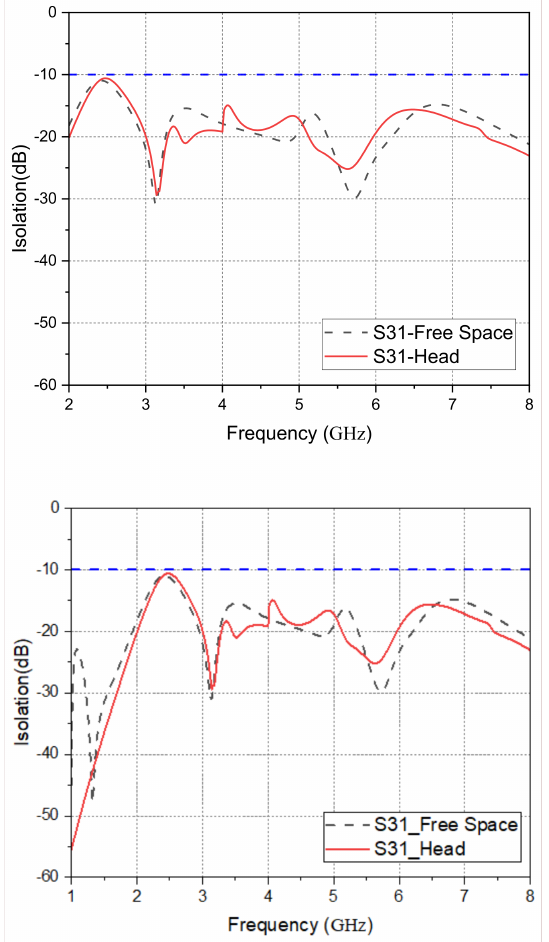
Figure 33. The isolation degree of the simulated free-space Ant. 1 and Ant. 3 and when worn on the